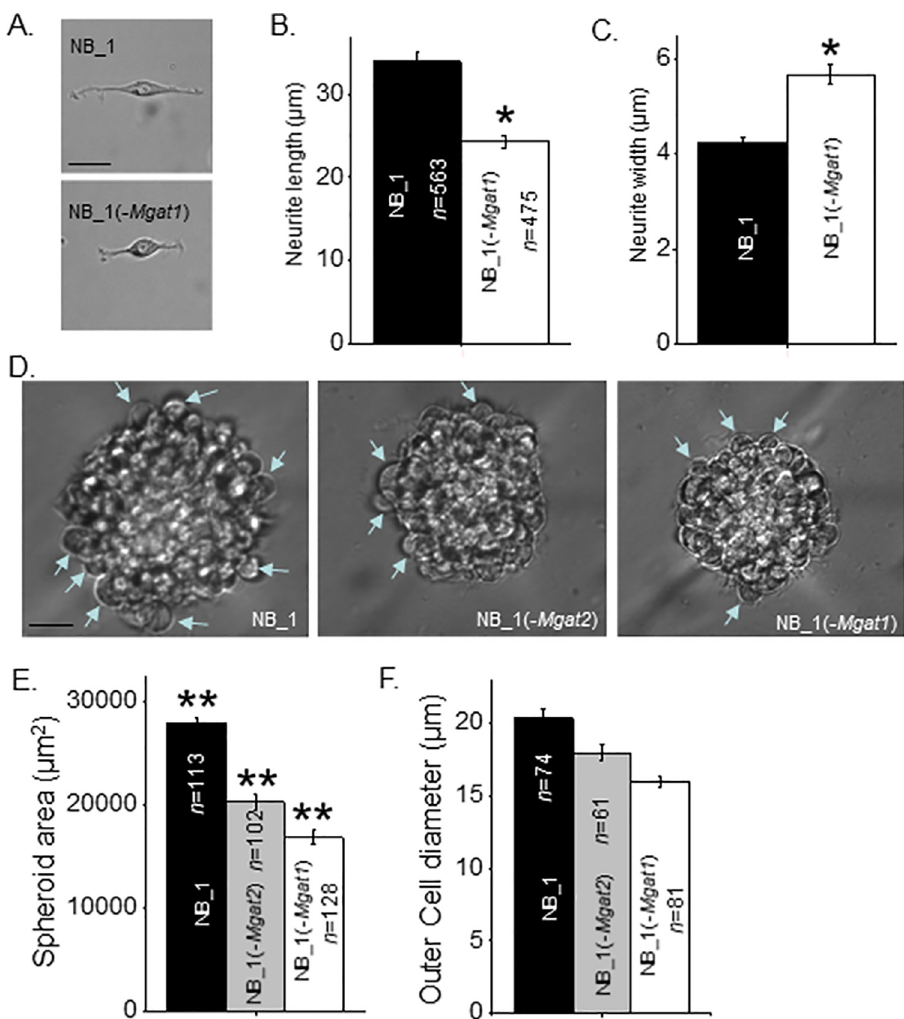
Fig 2. Morphology of NB cells and NB spheroids are dependent on the type of N-glycan. (A) Representative images of NB_1 and NB_(- Mgat1 ) cells from 2D cell cultures. Length (B) and width (C) of neurites from cells grown in 2D cell cultures. (D) Typical images of 7 days old spheroids obtained at 40x magnification. Blue arrowhead depicts measured cells at outer edge of sphere. (E) Quantification of spheroid size determined from images obtained at 10x magnification. (F) Diameter of cells at outer edge of sphere were quantified. Scale bars are 25 μ m. Data are presented as the mean ± SEM and were compared by one-way ANOVA followed by Holm-Bonferroni adjustment ( � p < 0.02, �� p < 0.001). n denotes the number of neurites, cell diameters or spheroids measured, respectively.